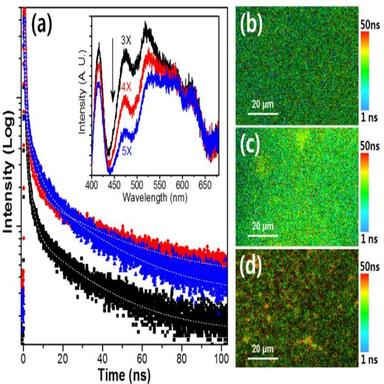
(a) Time-resolved PL decays of the CdIS/TONR/FTO. The overlapped dotted curves are fitted lines. The inset is the corresponding PL spectrum. The TRPL images of the corresponding PL decays are presented for the (b) (×3)-CdIS/TONR/FTO, (c) (×4)-CdIS/TONR/FTO, and (d) (×5)-CdIS/TONR/FTO specimens.